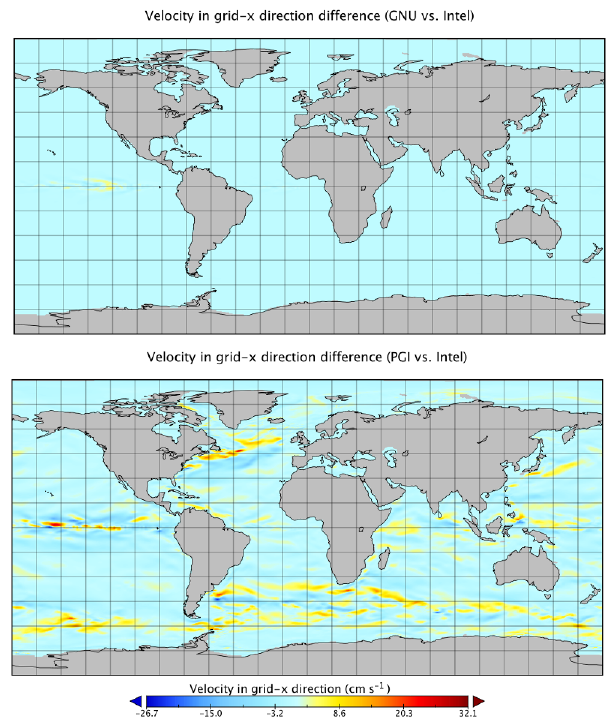
Figure 12. Differences in the top-level zonal velocity (UVEL) in cms − 1 at month 12. The top panel shows the differences between the GNU 14.8 and default Intel simulation output. The lower panel shows the differences between PGI 13.9 and the default Intel 13.1.2 simulation outputs. Note that the min, max, and mean data values for UVEL for the default Intel 13.1.2 simulations at month 12 (top- level) are − 80.9, 77.0, and − 0.8cms − 1 , respectively. For compari- son, the min, max, and mean data values for UVEL are − 87.9, 69.8, and − 0.9cms − 1 for the PGI 13.9 simulation